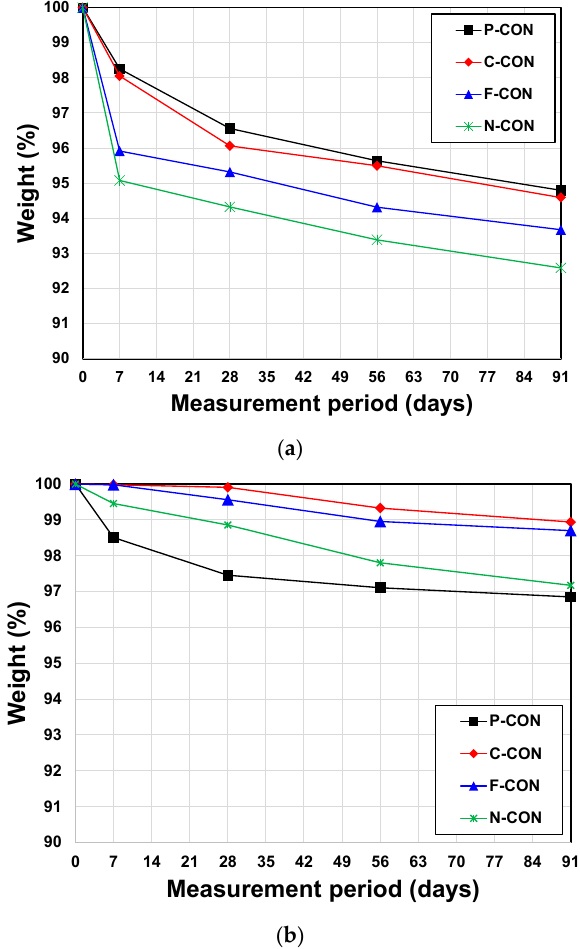
Figure 7. Chemical resistance test results: ( a ) 5% HCl solution and ( b ) 5% H 2 SO 4 solution. XRD and TG/DTG Analysis in Chemical Resistance Tests